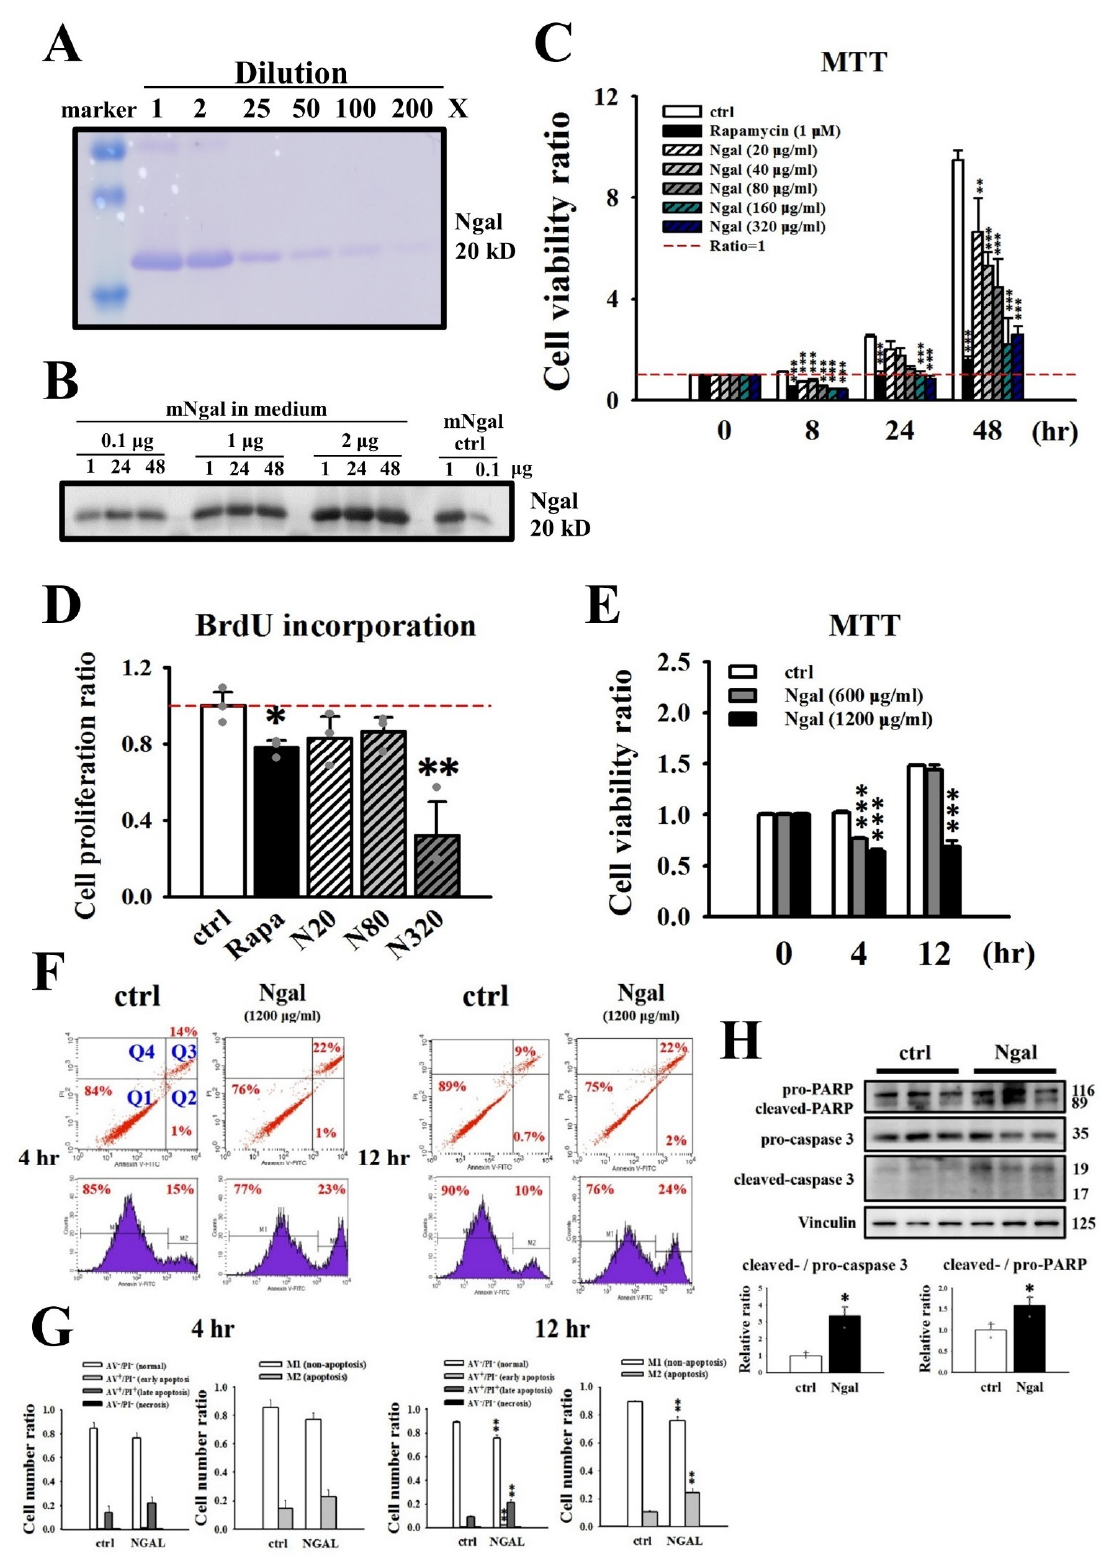
Figure 3. Effects of addition of mNGAL on cell viability and proliferation of 2L3 cells. ( A ) The result of SDS–PAGE showed that mNGAL (without signal peptide) purified from E. coli had a main 20-kD band and a light 40-kD dimer signals. ( B ) Western blot showed that mNGAL could be stably